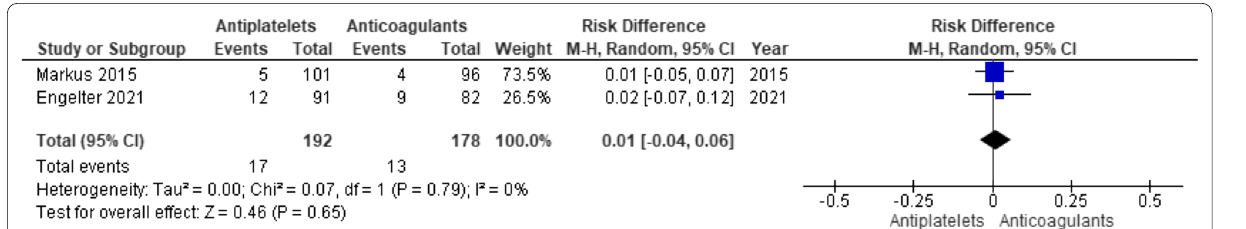
Fig. 6 Forest plot for stroke or TIA outcome for